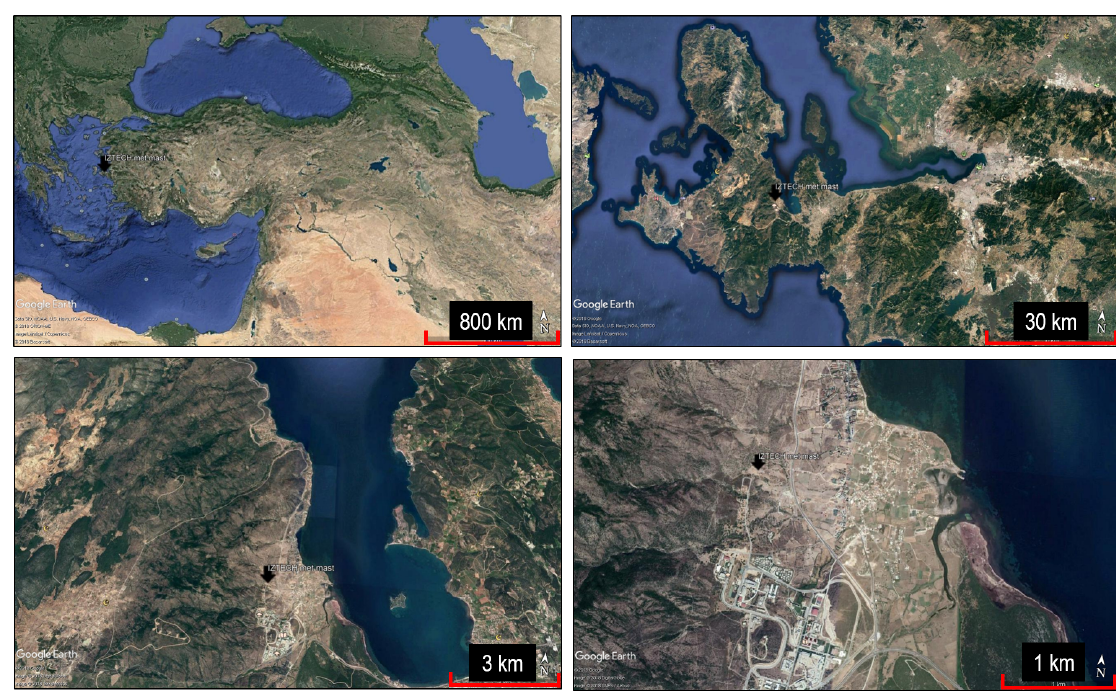
Figure 1. The location of the IZTECH met mast.